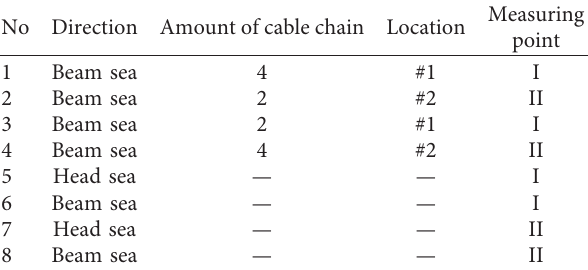
Figure 5: Mooring diagram of bow and stern and multipoint mooring. (a) Mooring at bow and stern. (b) Multipoint mooring. Table 4: Working